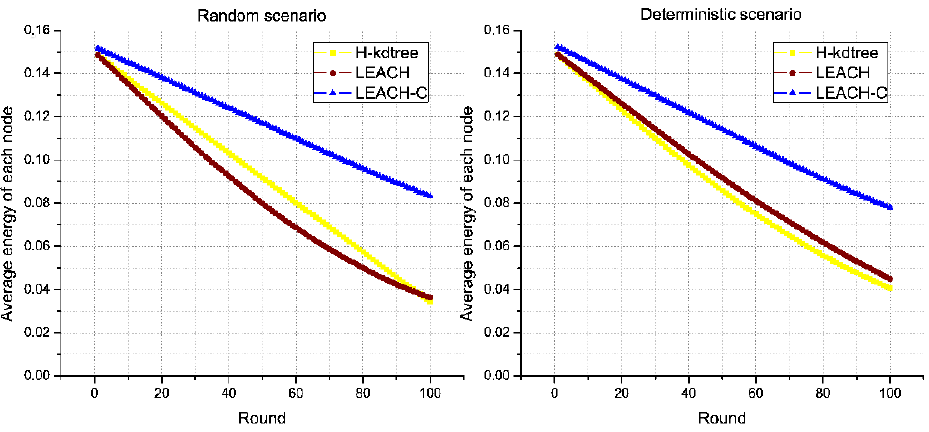
Figure 13. Average